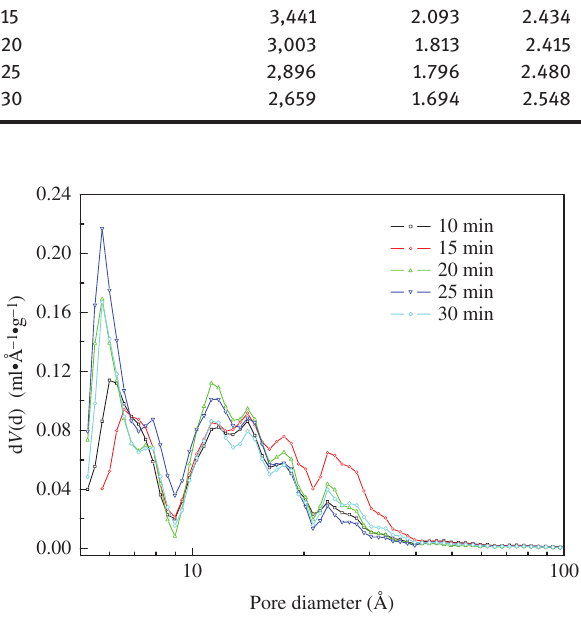
Figure 6: Pore size distribution chart for different microwave heating